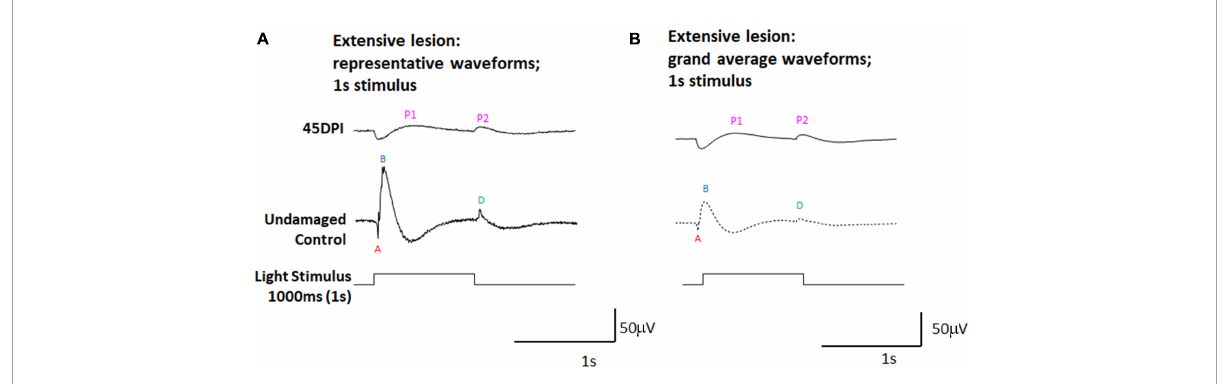
FIGURE2 ERG waveforms in response to a 1,000 ms light flash, in undamaged controls and at 45 days post-injury (DPI) following an extensive lesion. (A) Representative waveforms. (B) Grand average waveforms. A, a-wave; B, b-wave; D, d-wave; P1 and P2, first and second post-photoreceptor